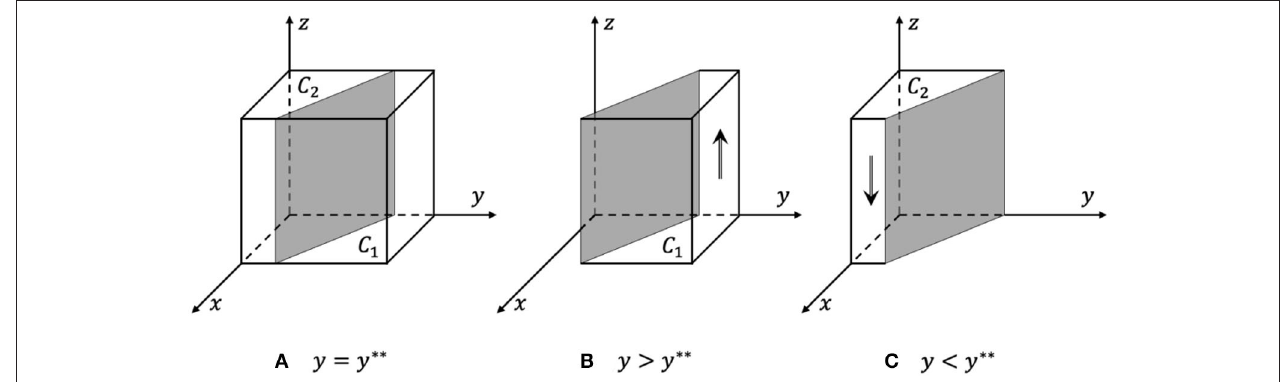
FIGURE 4 | Phase diagram of rights holders’ strategy evolution. (A) y = y**, all strategies are in a stable state. (B) y > y**, z = 1 are the evolutionarily stable strategy. (C) y < y**, z = 0 are the evolutionarily stable strategy.